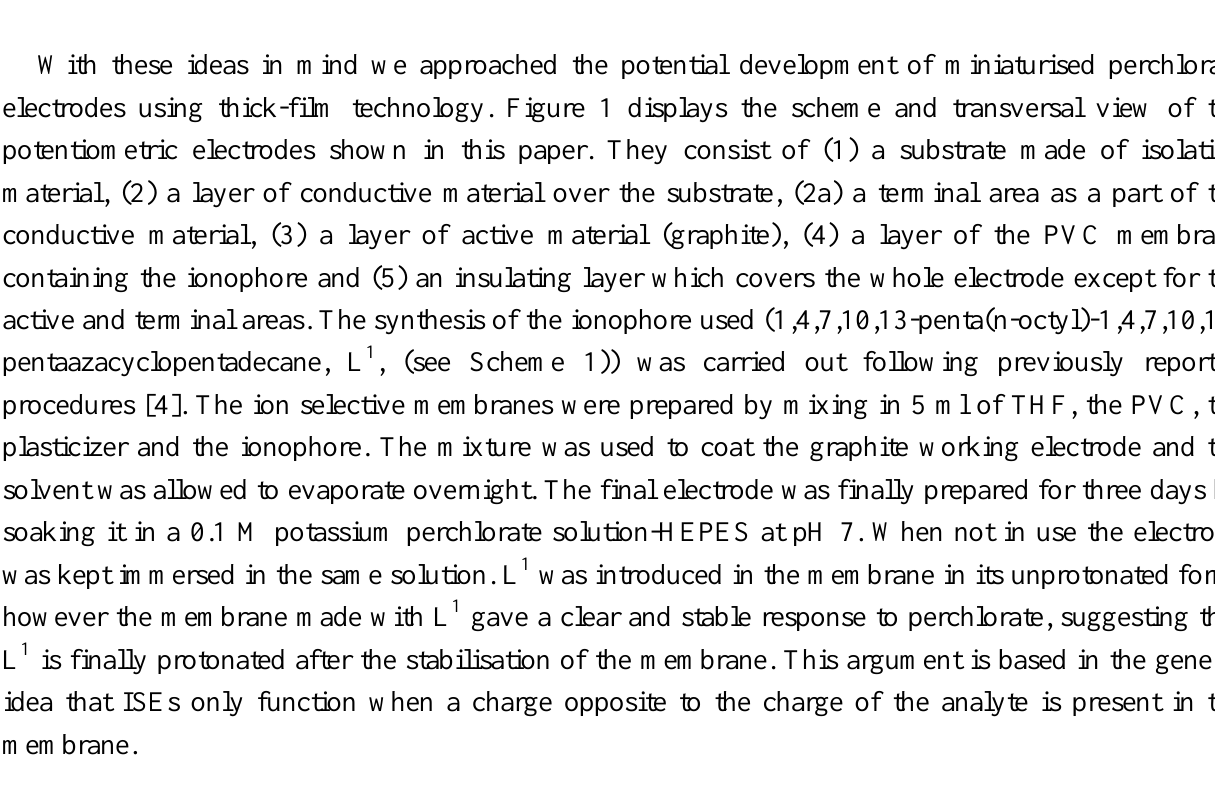
Figure 1. Schematic representation and transversal view of the